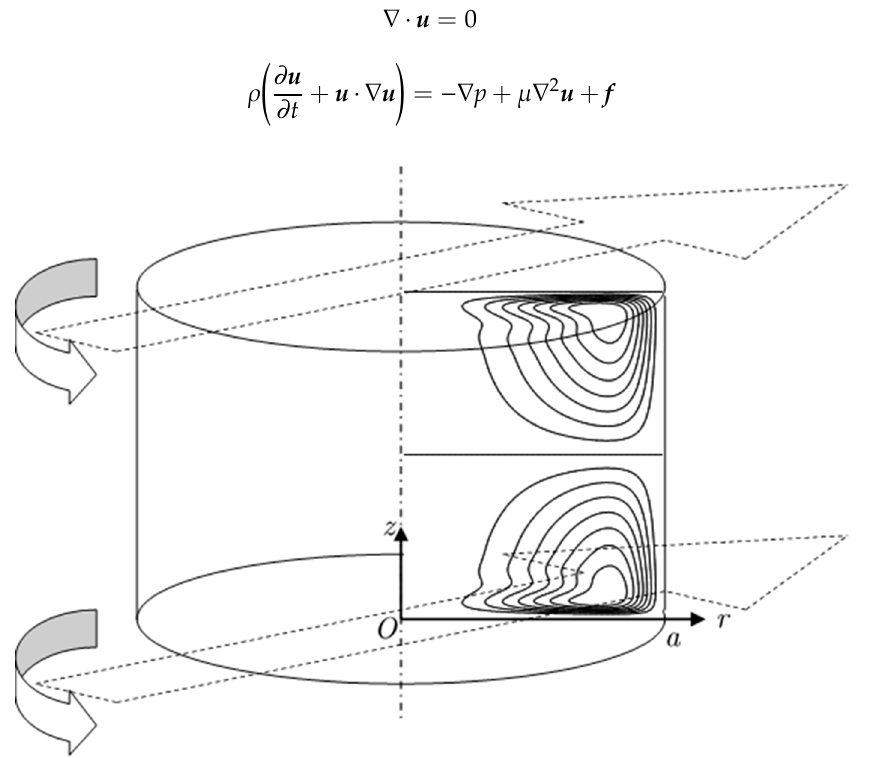
Figure 1. Schematic model for the problem. The arrows indicate the instantaneous direction of magnetic field, which rotates in a counterclockwise direction, for the case of m = 1. The contour lines in a cross-section indicate an example of the meridional stream line.